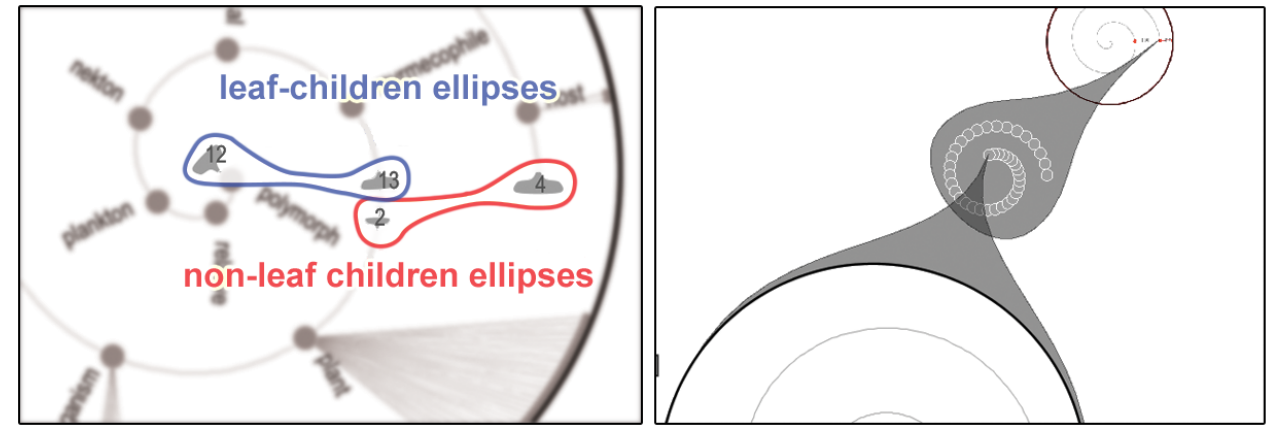
Figure 6. Types of elision in PaisleyTrees: descendant ellipses (left), an ancestral ellipsis (right). distributed at identical distances to support